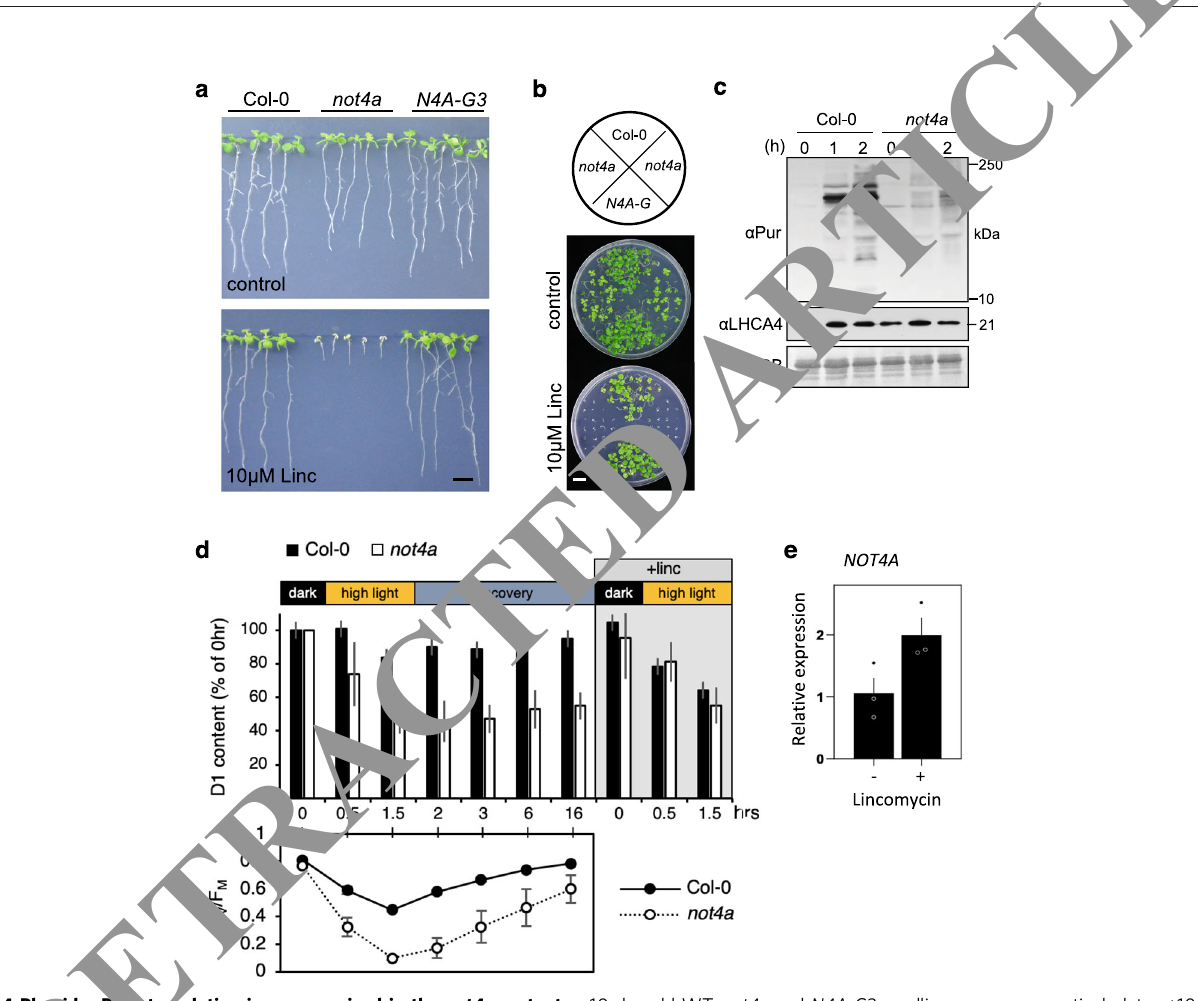
Fig. 4 Plastid mRNA translation is compromised in the not4a mutant. a 10-day-old WT, not4a and N4A-G3 seedlings grown on vertical plates ±10 µ M lincomycin. Bar = 1cm. b same as in a but on horizontal plates. Bar = 1cm. c Protein synthesis rates in Col-0 and not4a chloroplasts, determined by anti- puromycin ( α -Pur) western blot following a 2-h puromycin treatment time course. LHCA4 and CBB (Coomassie Brilliant blue) are shown as loading controls. Experiment was repeated at least three times with similar results. d The amount of D1 protein (% of 0h) and PSII ef fi ciency (F V /F M ) during a photoinhibitory treatment at 1000 μ mol photons m − 2 s − 1 with and without lincomycin (linc) and during recovery without linc at 100 μ mol photons m − 2 s − 1 . Total leaf protein extracts were separated on an SDS-PAGE, immunoblotted with a D1-speci fi c antibody and quanti fi ed with LI-COR imaging. Averages from three biological replicates are presented with ±SEM error bars. Source data are included in the Source Data fi le. e Quantitative RT-PCR (qPCR) of NOT4A in 14-day-old Col-0 lines grown on media ±10 µ M Lincomycin. Expression levels normalised to ACTIN7 and shown relative to untreated Col-0. Averages from three biological replicates are presented with ±SEM error